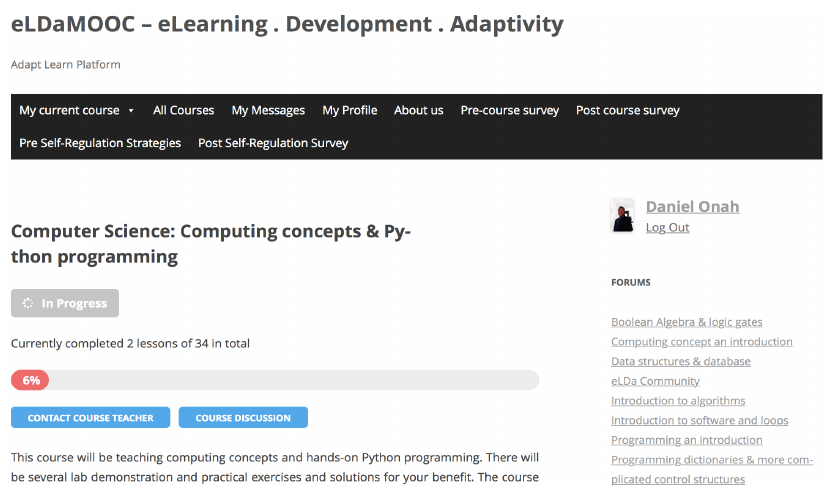
Fig. 2. Visualisation of the course